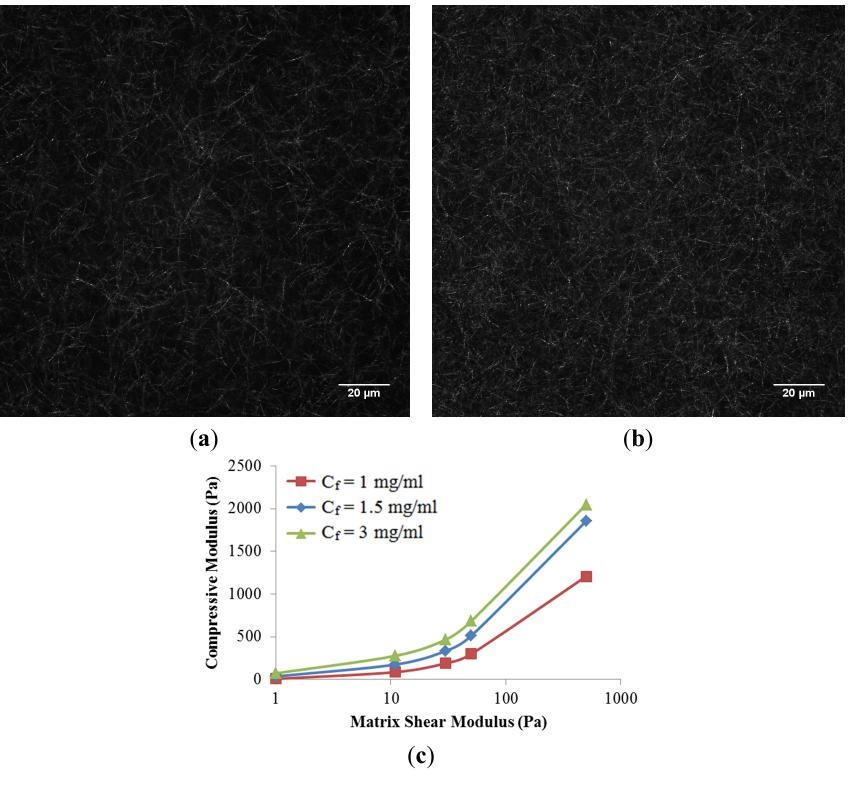
Figure 5. Confocal reflectance microscopy images of scaffold at the collagen concentration ( C f ) of ( a ) 1.5 mg/mL, and ( b ) 3.0 mg/mL, respectively; ( c ) Compressive Modulus of collagen scaffolds in response to collagen concentrations and matrix shear modulus.